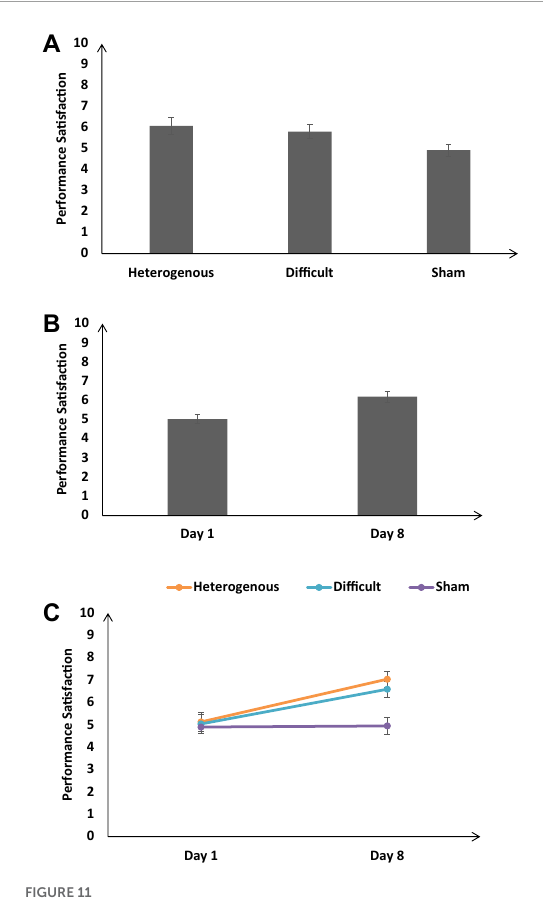
FIGURE11 (A) The self-reported performance satisfaction across different training conditions. (B) The performance satisfaction across different baseline days (Day 1 and Day 8). (C) The performance satisfaction across different training conditions and baseline days (Day 1 and Day 8). The error bars show 95% CI around point estimates.